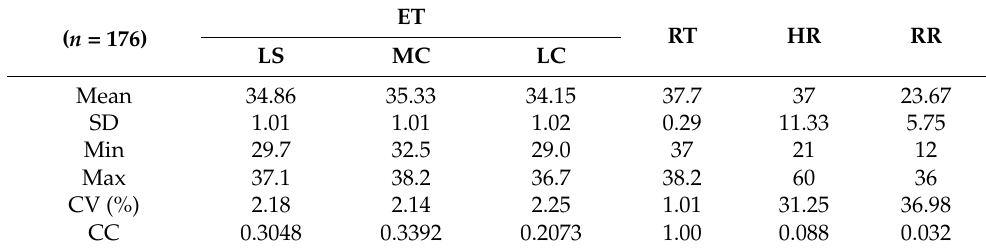
Table 2. Correlation between eye temperature (ET, ◦ C: left and right) and heart rate (HR, beat/min), and respiratory rate (RR, cycles/min) for each instance of rectal temperature (RT, ◦ C) recorded in 176 horses.